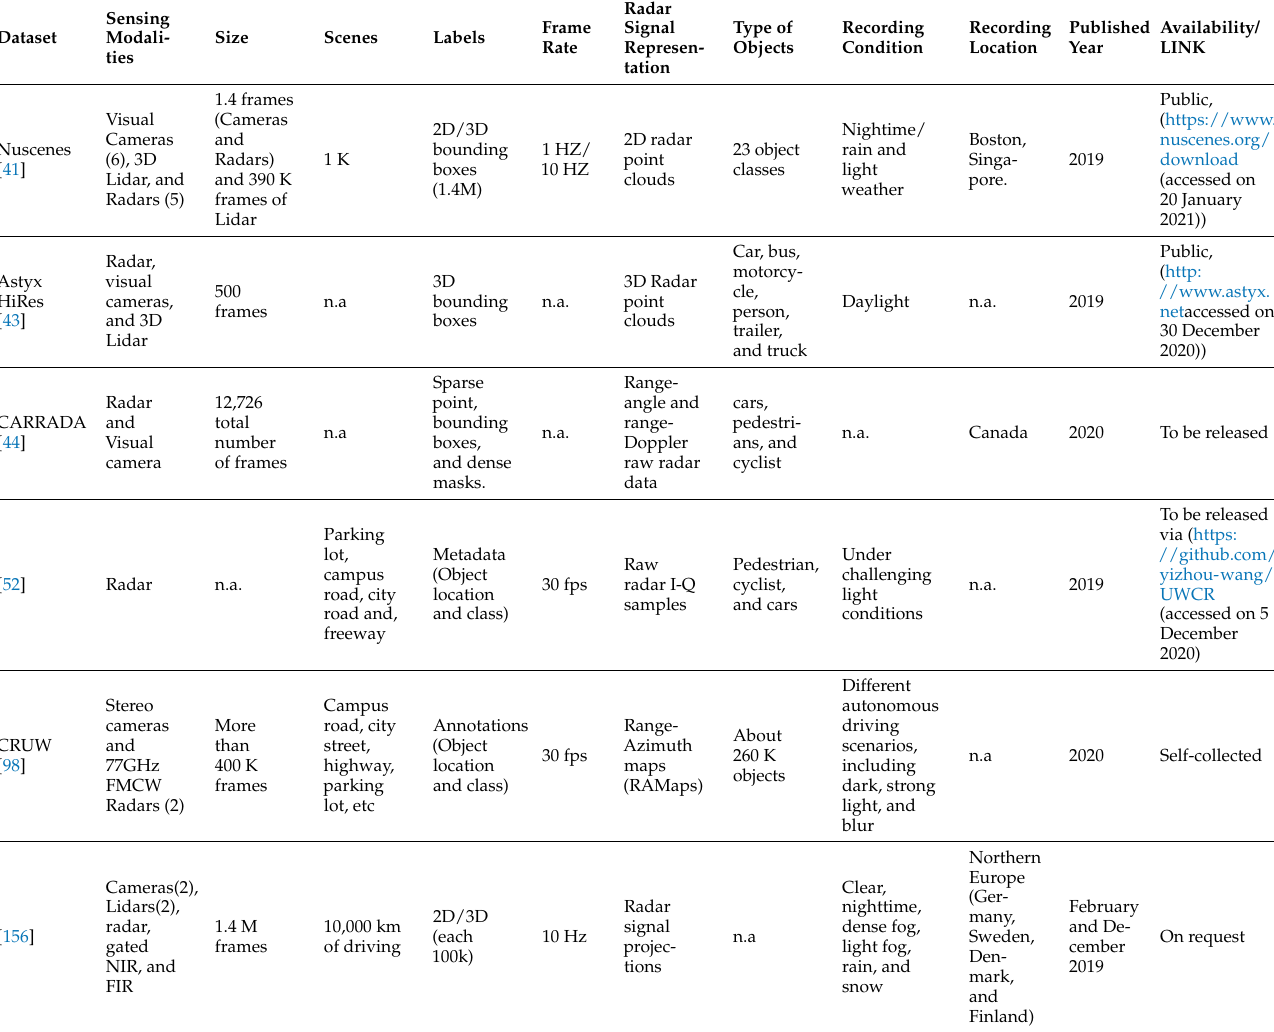
Table 3. A summary of the available datasets containing radar data and/without other sensors